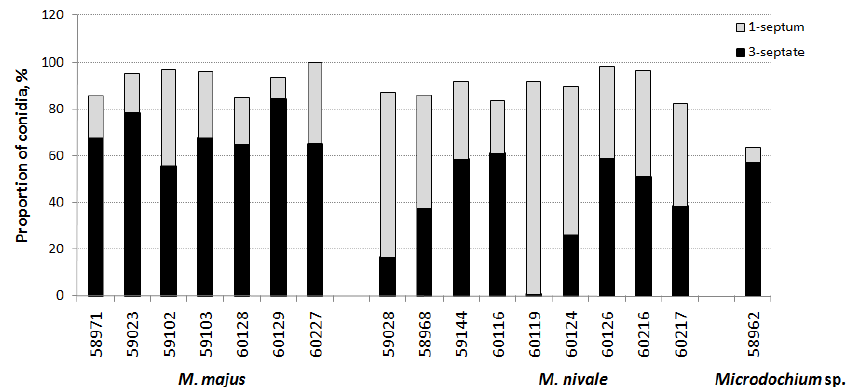
Figure 5. Proportion of macroconidia with one septum and three septa in Microdochium fungi on PSA.